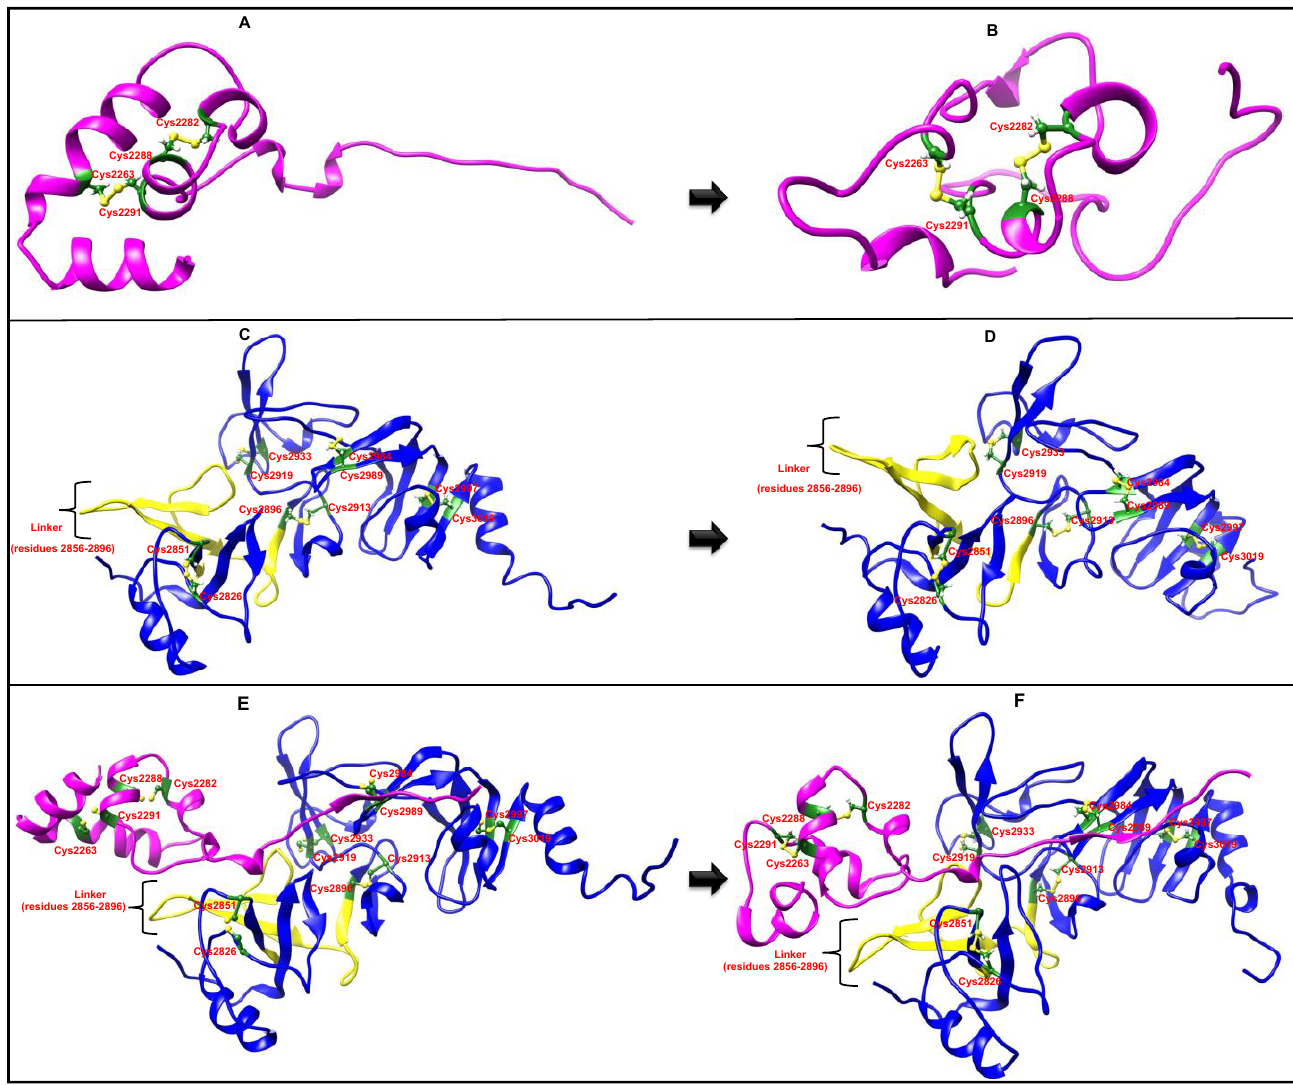
Figure 4. Comparison of the nsp3 and nsp4 lumenal regions either in complex or alone and their energetically most favourable structures after MD simulation. ( A ) Initial structure of nsp3 predicted alone with ColabFold prior to MD simulation. ( B ) The 77 ns energetically most favourable structure of the nsp3 lumenal region predicted with ColabFold. ( C ) Structure of the nsp4 lumenal region predicted alone. ( D ) The 150 ns MD simulation structure of the nsp4 lumenal region predicted alone. ( E ) Pre-MD structure of the nsp3/nsp4 lumenal regions predicted with ColabFold in complex. ( F ) The 85 ns MD simulation structure of the nsp3/nsp4 lumenal regions predicted with ColabFold in complex. nsp3 is shown in magenta and nsp4 is shown in blue. The linker region in the nsp4 lumenal region is coloured in yellow. Cysteine residues are highlighted in green.